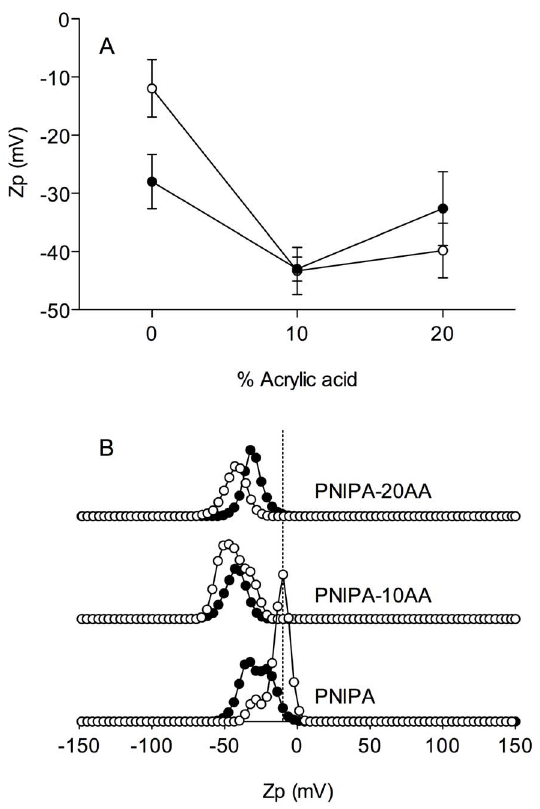
Figure 3. Mean zeta potential (Zp) (A) and zeta potential N distribution (B) of PNIPA/AA nanohydrogels. Nanohydrogels with ) of the cross-linking (CL) degree were previously 3% ( # ) and 5% ( swelled and measured in distilled water (pH 5.5) at 25 u C.